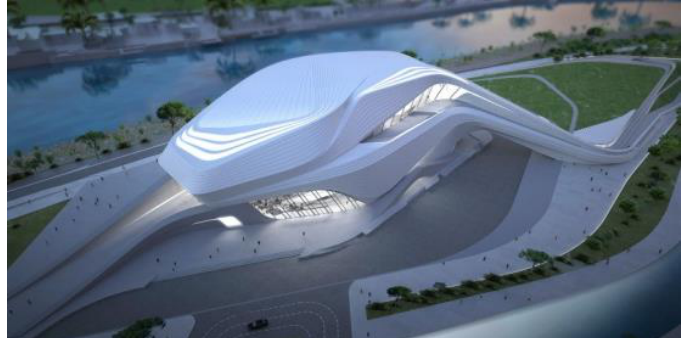
Figure 1 : The Tower Maroc Télécom”-Hay Riad-Rabat